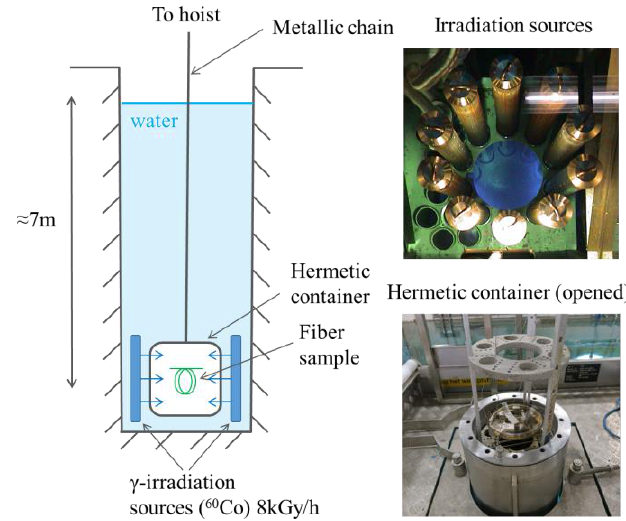
Fig. 1. Schematic and photographs of the irradiation